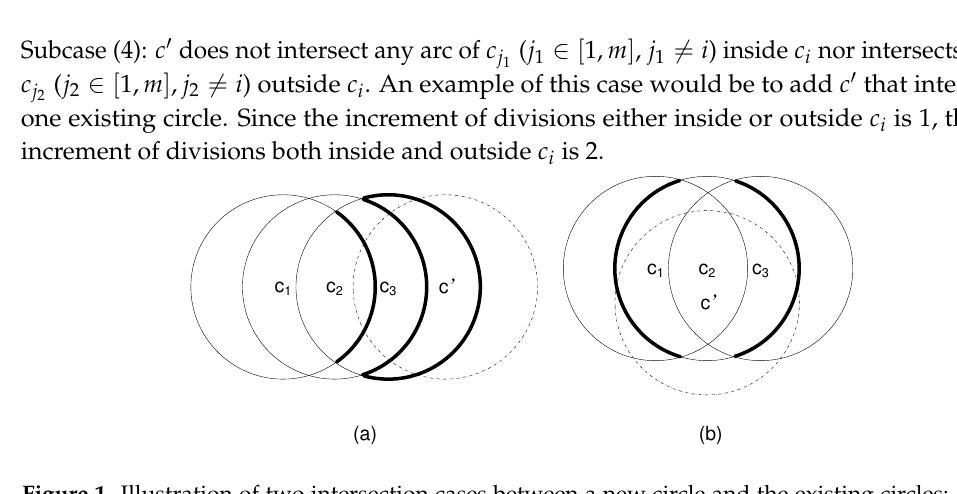
Figure 1. Illustration of two intersection cases between a new circle and the existing circles: ( a ) the new circle c (cid:48) intersects only one arc of an existing circle; ( b ) the new circle c (cid:48) intersects two arcs of an existing